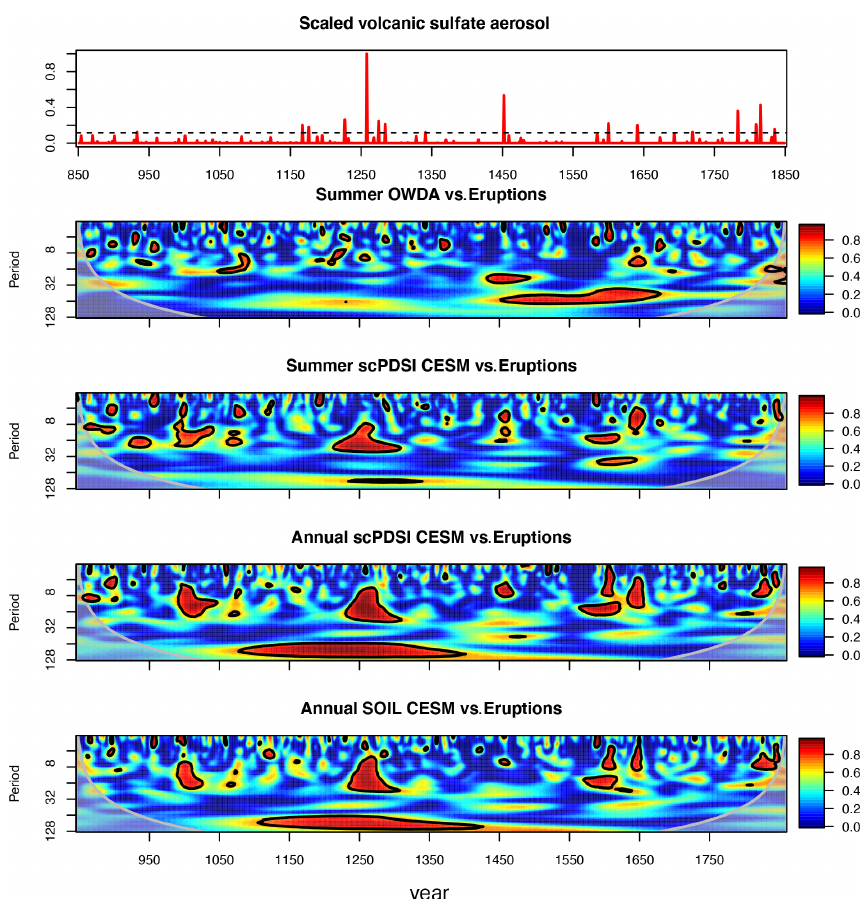
Figure 6. Time series of scaled total stratospheric sulfate aerosol injections for the volcanic eruptions in 850–1849CE (Gao et al., 2008) (top panel). The dashed black line indicates the threshold for large eruptions with a stratospheric sulfate aerosol loading of more than 30Tg. Wavelet coherence analysis between the time series of volcanic eruptions and the drought indices (lower panels). The red shaded regions are where the coherences of two time series are statistically significant at the 95% confidence level, as estimated from Monte Carlo resampling of the time